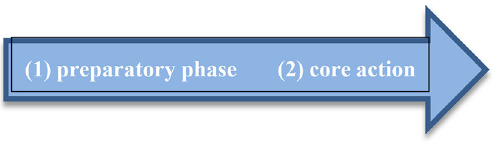
Figure 4: Phases of embodied